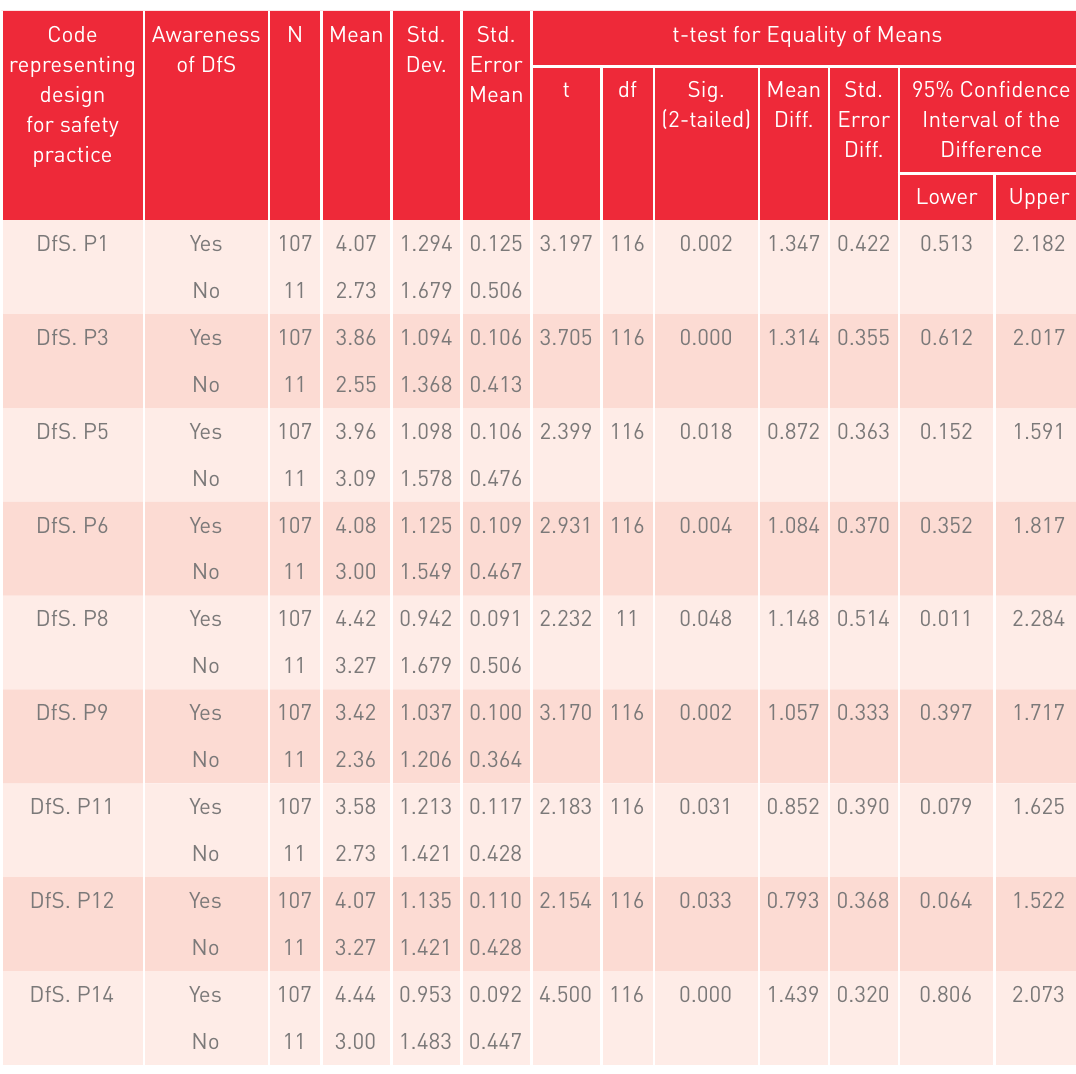
Independent samples t-test based on DfS awareness. Code